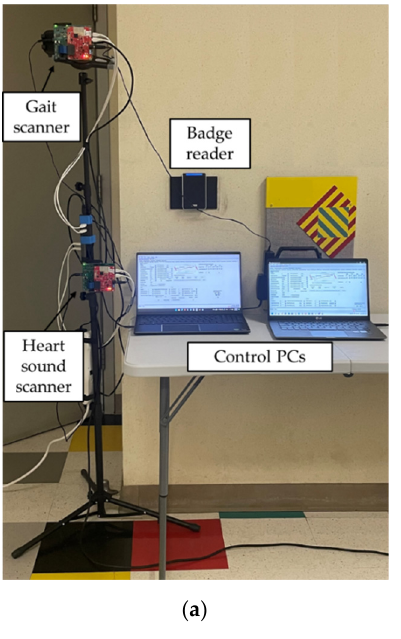
Figure 1. The data collection platform: ( a ) the complete setup incorporating two millimeter-wave radar sets and two laptops; ( b ) a radar set composed of radar module (front) and capture card (back).